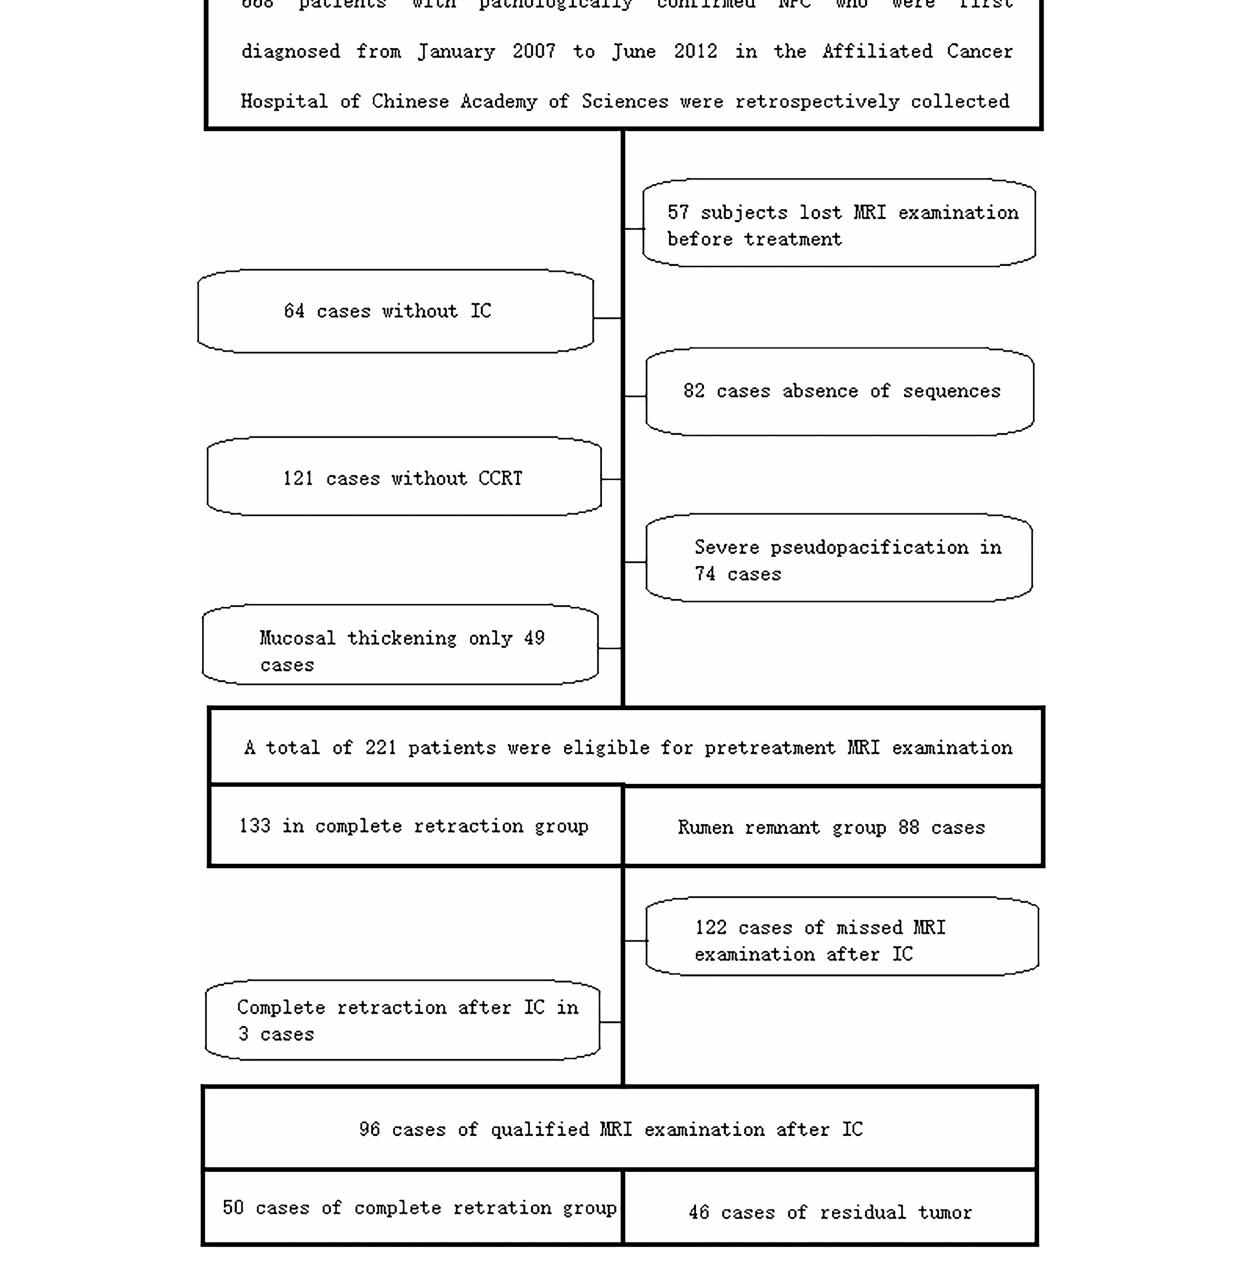
FIGURE 1 | The case screening process in the training set and internal validation set. A total of 221 quali fi ed cases were screened before the fi nal treatment, including 96 quali fi ed cases after IC. IC, induction